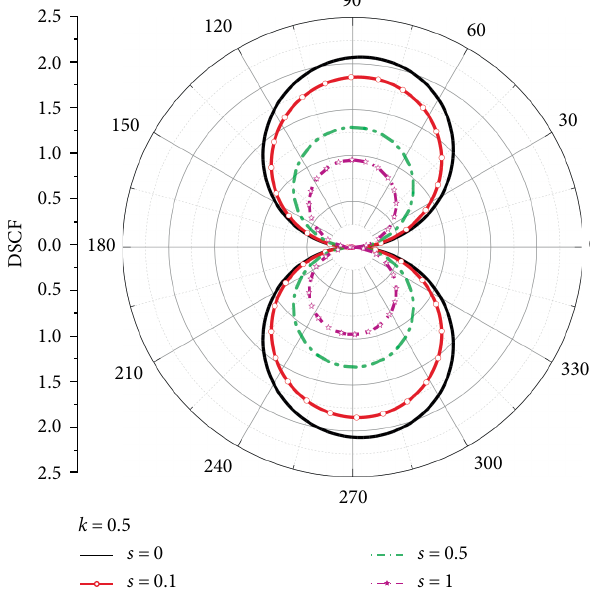
Figure 3: Distributions of DSCF around a circular hole with various 𝑠 for 𝐾 = 0.5